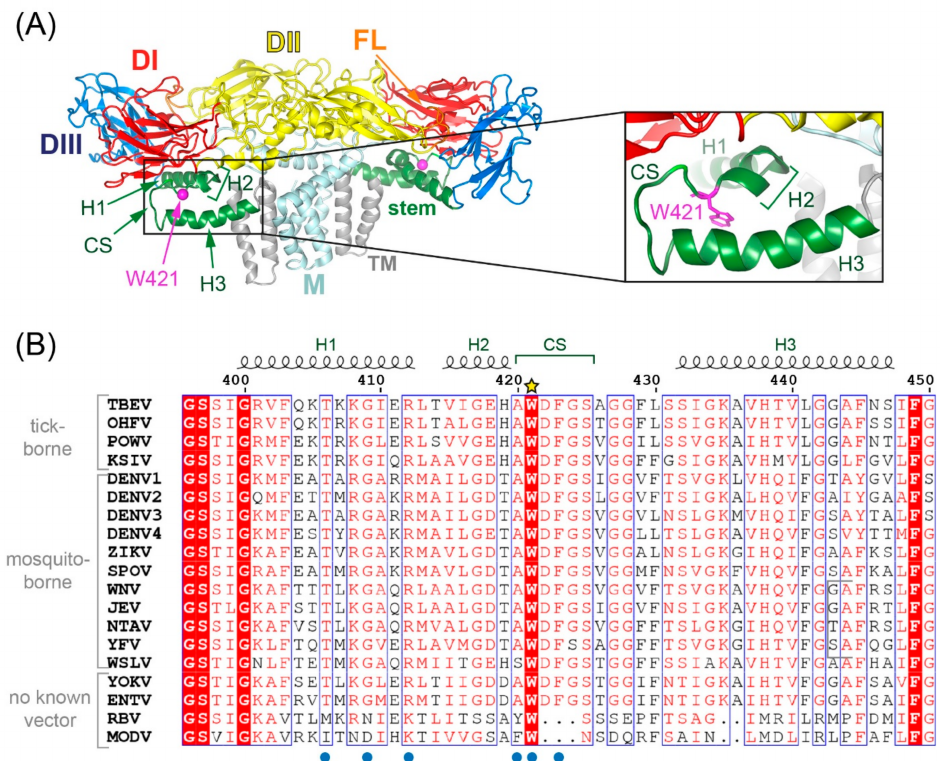
Figure 1. Structure of the TBEV (E-M)2 dimer on the surface of mature virions and an alignment of amino acid sequences of the stem. ( A ) Ribbon diagram of TBEV E and M proteins as a building block of mature virions (PDB 5o6a [9]). Color code: domain I (DI), red; domain II (DII), yellow; domain III (DIII), blue; fusion loop (FL), orange; stem, green; transmembrane (TM) domains, gray. Inset: Close-up of residue W421 in CS of the stem. The structures were generated with PyMol (https://pymol.org, accessed on 5 July 2021). ( B ) Sequence alignment of stem regions of different flaviviruses using MAFFT (https://www.ebi.ac.uk/Tools/msa/mafft, accessed on 5 July 2021) and ENDscript (http://espript.ibcp.fr/ESPript/ ESPript/, accessed on 5 July 2021) [19]). The yellow star above the sequences labels the conserved tryptophan targeted